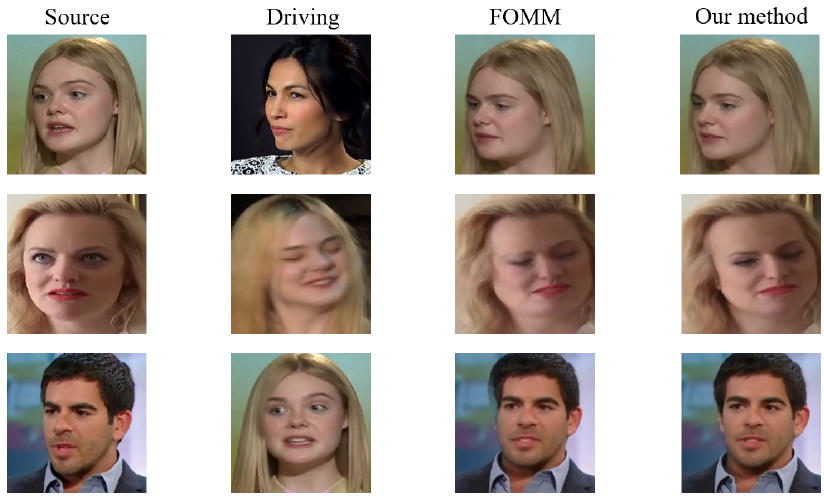
Figure 12. Comparison between our method and FOMM on the VoxCeleb1 dataset.